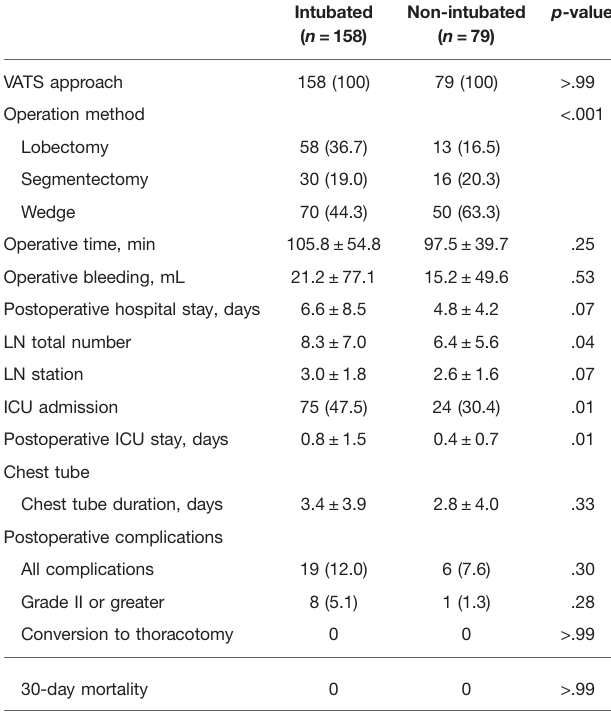
TABLE 2 | Perioperative outcomes after propensity score matching.